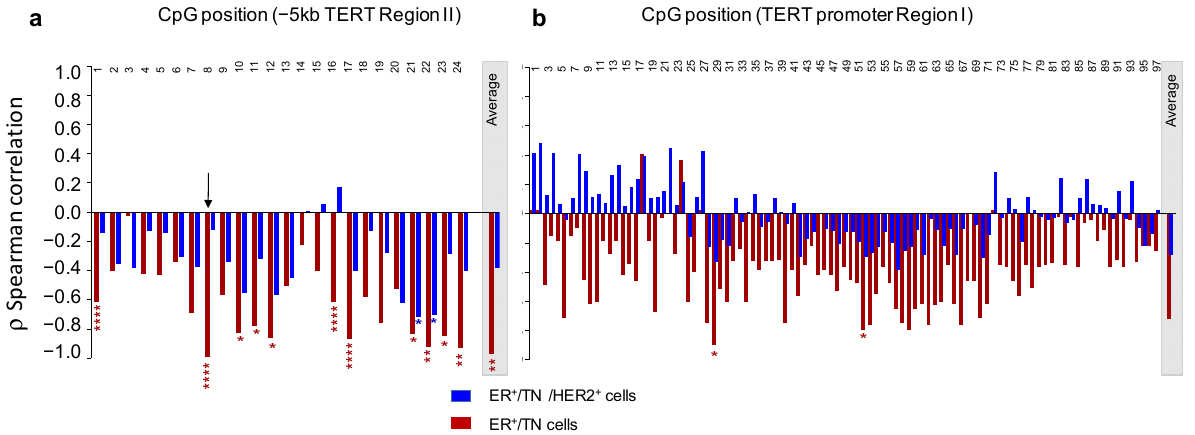
Figure 5. ρ Spearman correlation between TERT regulation after ATRA treatment of cells and CpG methylation levels for either − 5 kb TERT region II ( a ) or TERT promoter region I ( b ). Blue bars: analysis was performed considering all cell lines. Red bars: HER2 + cells were excluded from the analysis. CpG positions of each studied region are indicated. In (a), the position of the remarkable CpG 8 (chr5: 1,300,438) is pointed out. “Average”: the overall methylation status for each region is specified in the grey box. Corresponding P -values are shown with each bar: * P < 0.05; ** P < 0.01; **** P < 0.0001.